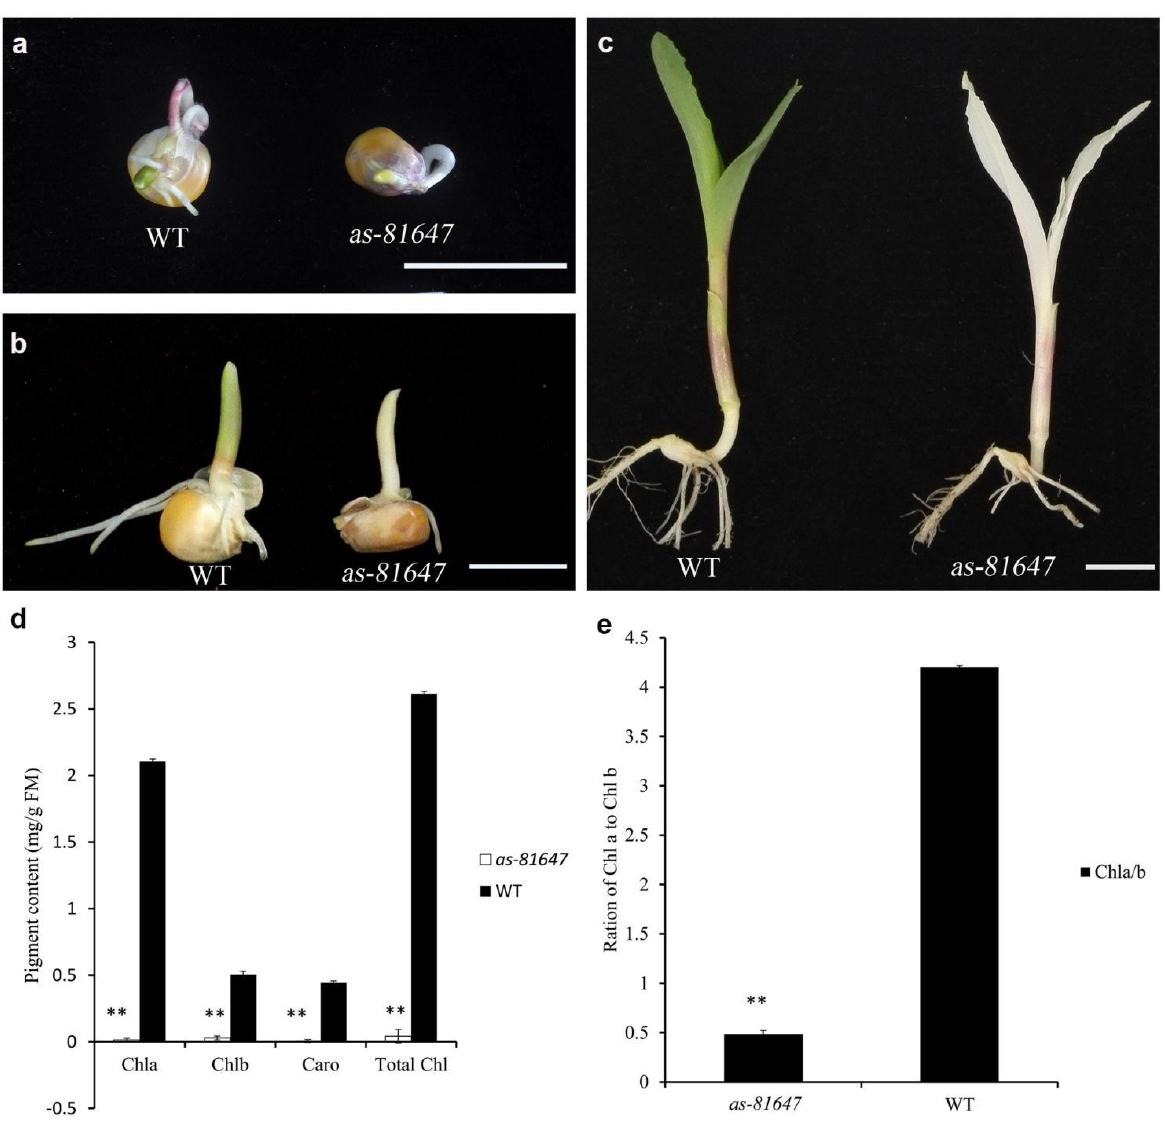
Figure 1. The phenotype of as-81647 . ( a – c ) Phenotypes of as-81647 after germination, at two days after planting (DAP) ( a ), 4 DAP ( b ), and 7 DAP ( c ). ( d ) Chl a, Chl b, Caro and total Chl content of WT and as-81647 . ( e ) The ratio of Chl a to Chl b of WT and as-81647 . Bar = 1 cm. ** P < 0.01 (Student’s t−test).